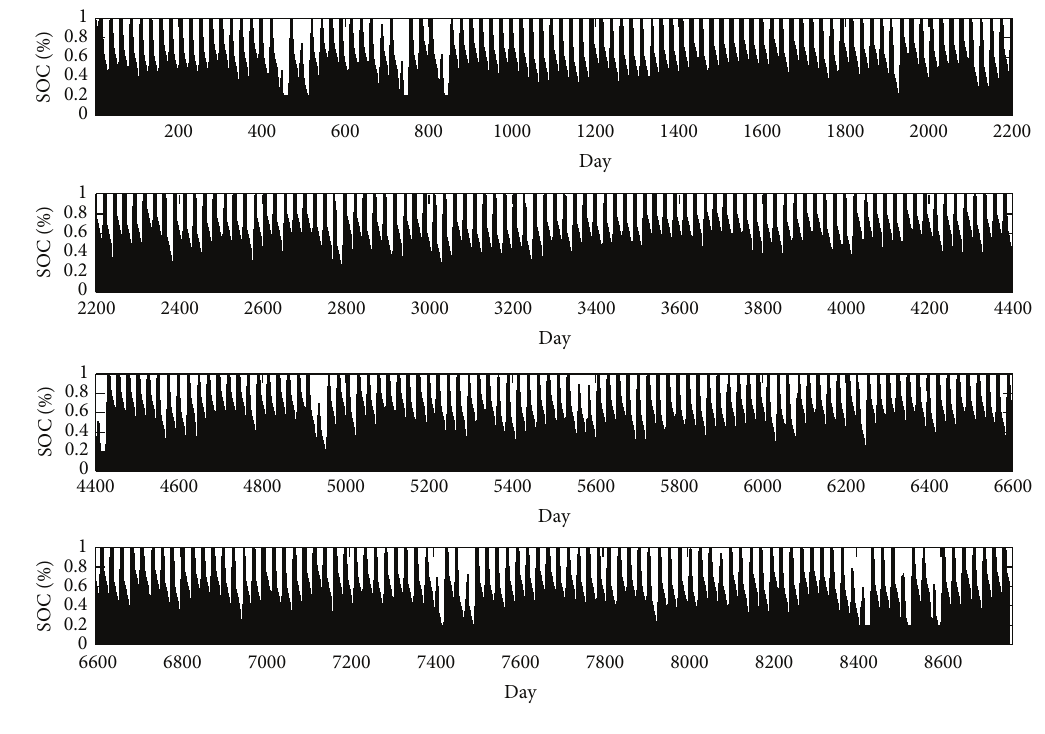
Figure 8: Battery storage SOC for the designed PV system.